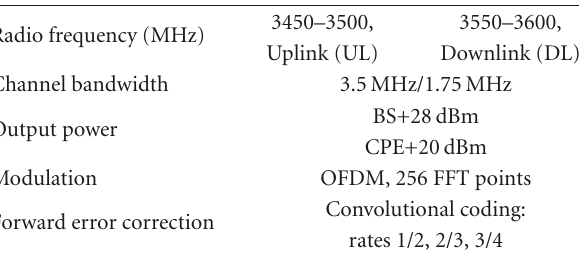
Table 1: Alvarion’s BreezeMAX radio specifications.